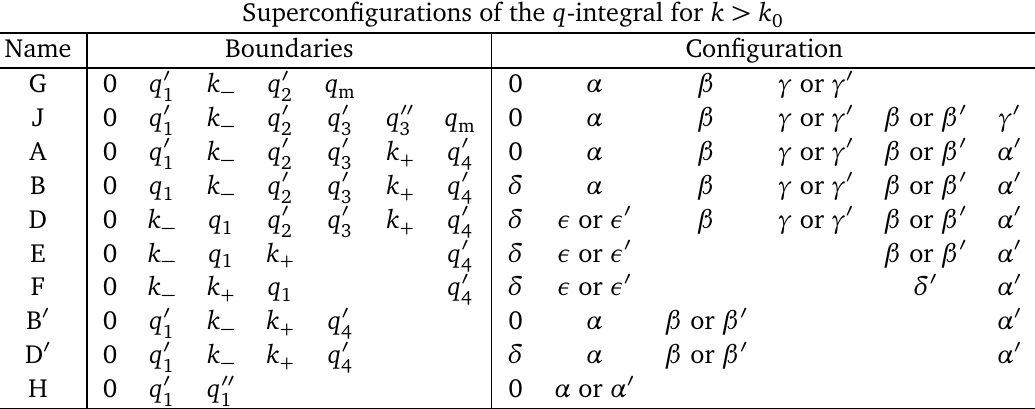
Table 3: Same table as Table 2 but for k > k boundary values of q .